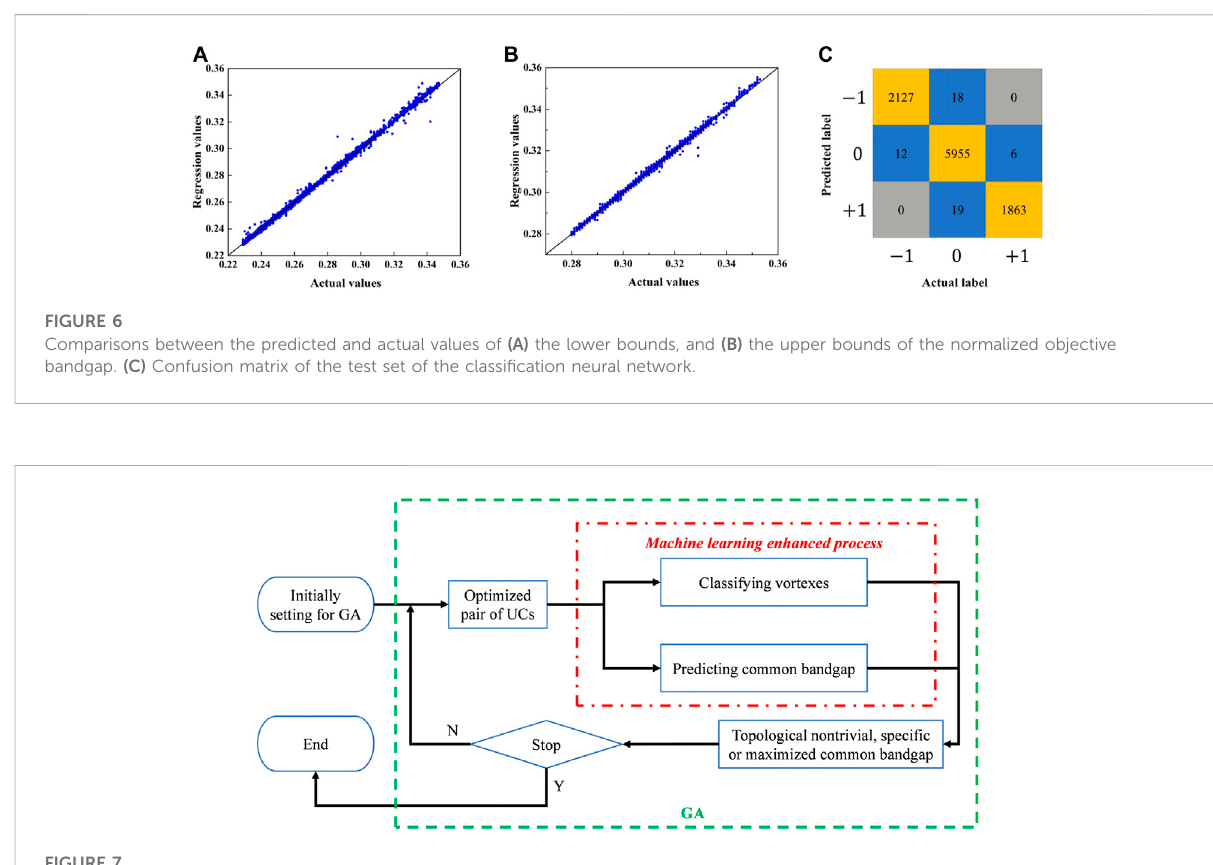
FIGURE 7 Flowchart of the design procedure of optimal design of valley Hall insulators.